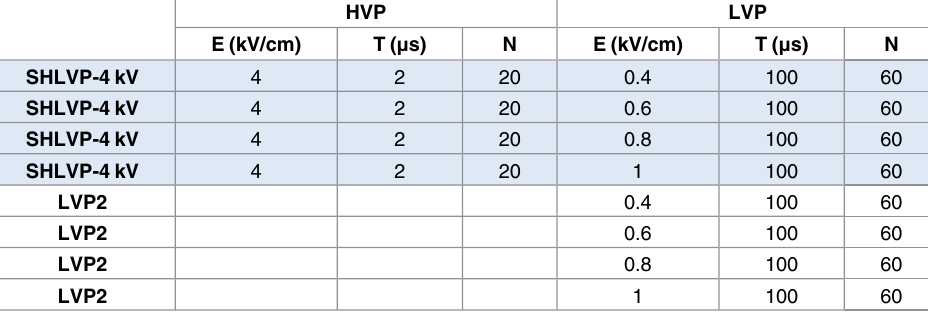
Table 4. Schemes for pulsation protocols with different LVP electric fields.